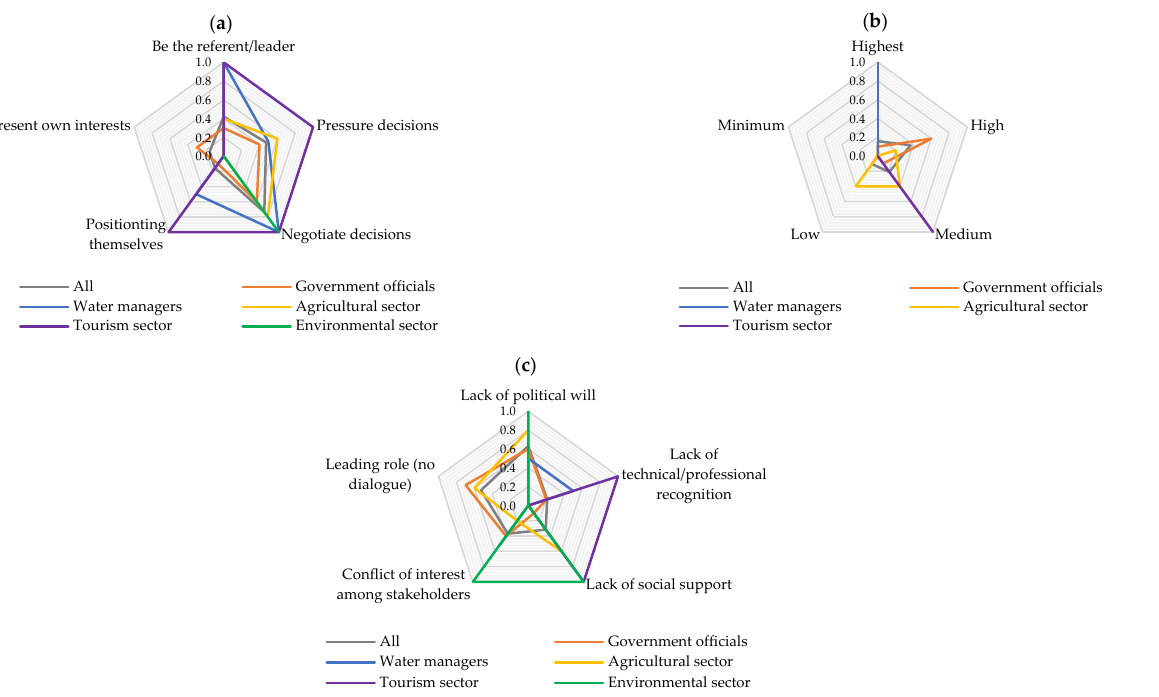
Figure 9. Feeling represented meaning and extension, while unrepresented reasons. ( a ) ‘Feeling